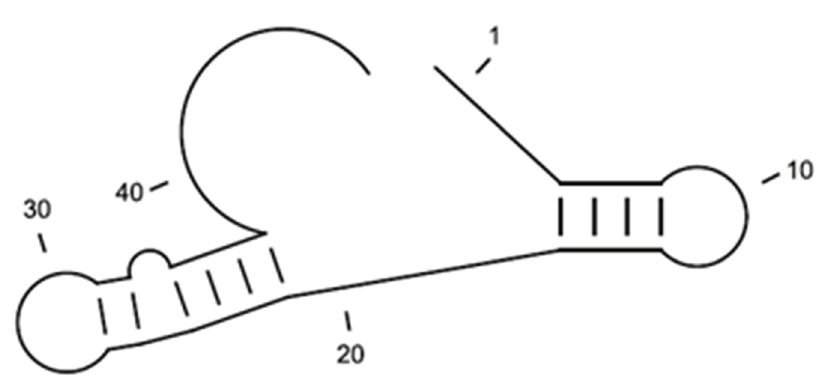
Figure 5. Predicted secondary structure of aptamer